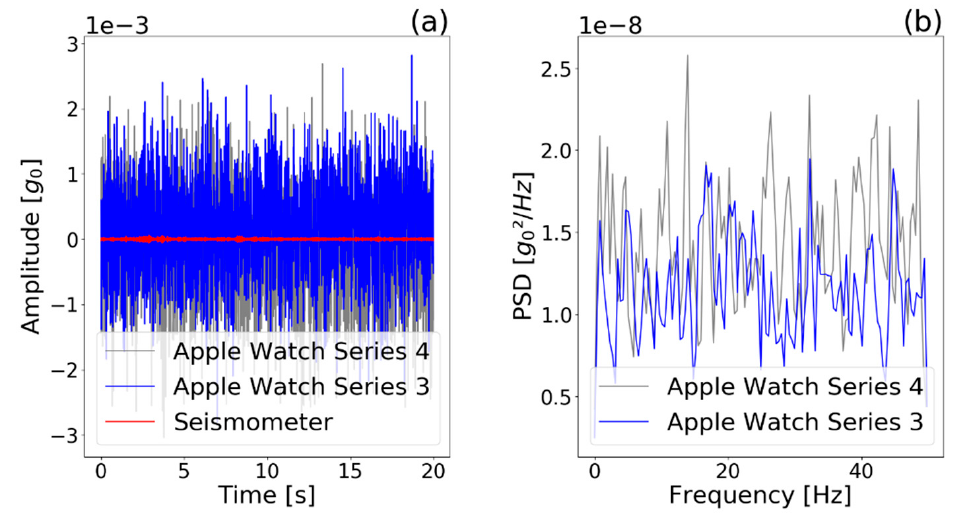
Figure 5. ( a ) Self noise of watches and seismometer and ( b ) power spectral density (PSD) of watches, captured during a 20-s period without vibration of the shaker table. The power spectral density shows that the noise of the smartwatches had a similar intensity at all frequencies covered. However, Apple Watch 4 had a slightly higher self noise.